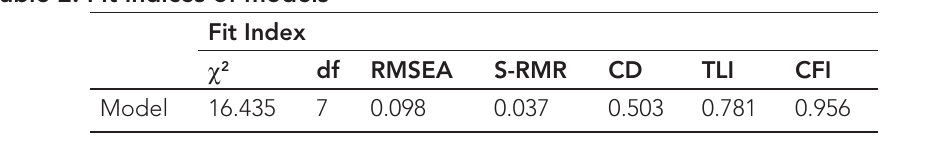
table 2: fit indices of models